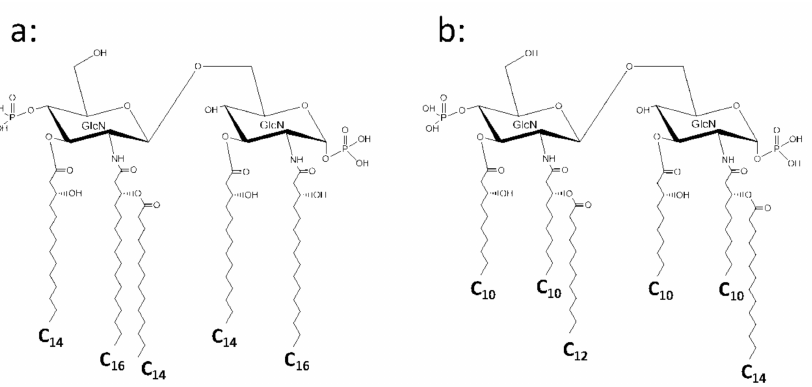
Figure 3. Chemical structure of lipid A from Burkholderia cepacia ( a ) and Comamonas testosteroni ( b